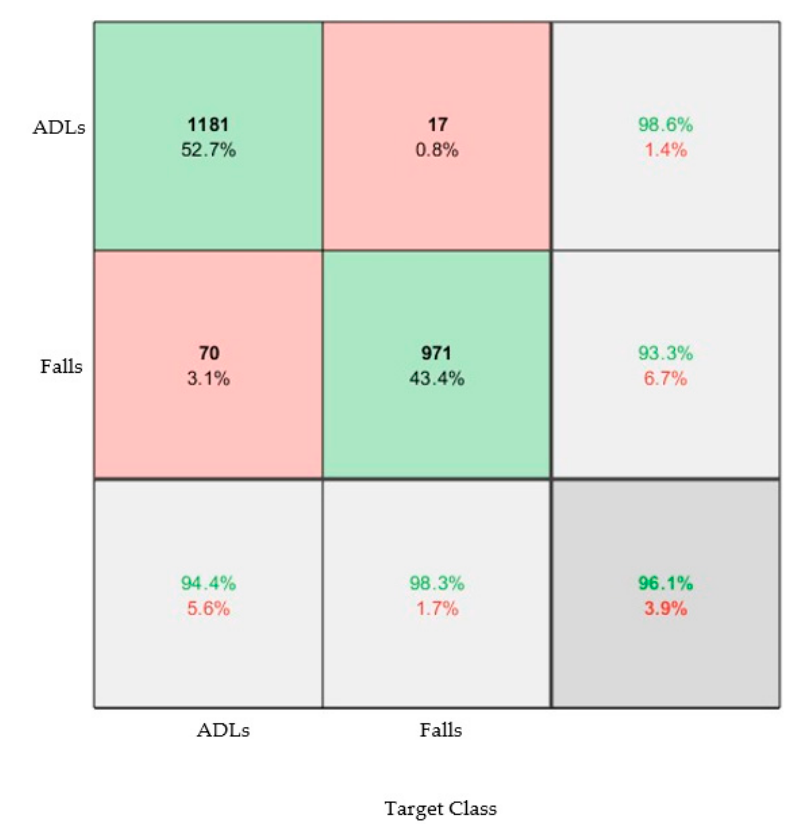
Table 2. Overall accuracy of the acceleration, angular velocity and both combined on each foot in ‐ dividually and both together. Values have been taken from the confusion matrices.